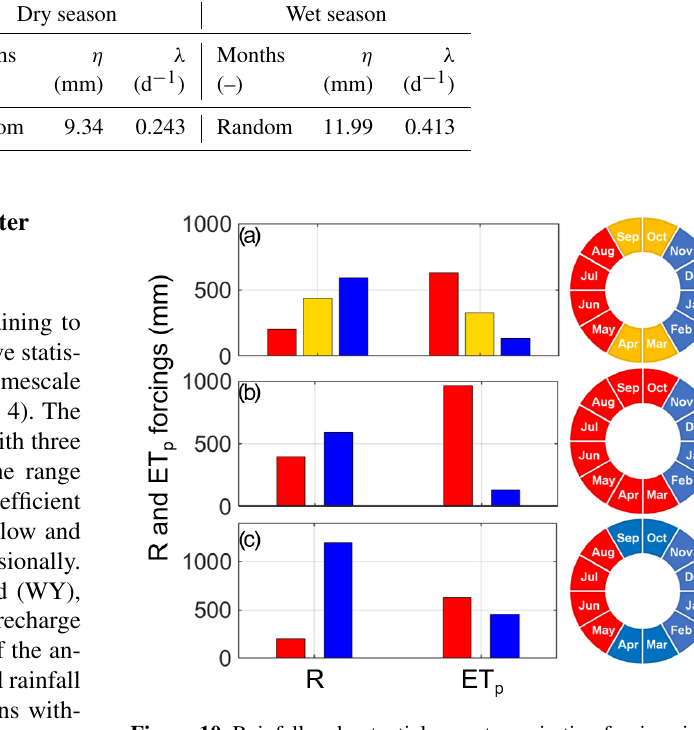
Figure 10. Rainfall and potential evapotranspiration forcings in the static approach, namely seasonal rainfall ( R ) and potential evapo- transpiration (ET p ) in the dry (red bars), transition (orange bars), and wet seasons (blue bars). Three scenarios are presented: (a) ref- erence scenario with the dry, transition, and wet seasons all lasting 4 months; (b) dry scenario with the dry and wet seasons lasting 8 and 4 months, respectively; and (c) wet scenario with the dry and wet seasons lasting 4 and 8 months,